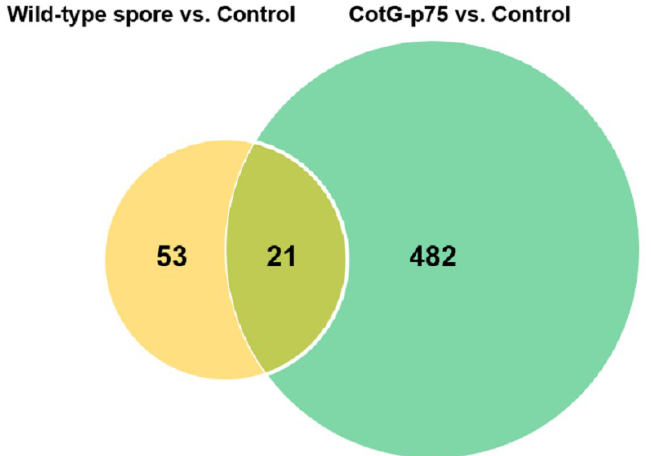
Figure 2. Venn diagram of differentially expressed genes (DEGs) in HT-29 cells stimulated with wild-type spore or CotG-p75 compared to control. Overlapping portions of different circles represent the number of DEGs that are common, and non-overlapping portions represent the number of DEGs that are unique to the comparison group.